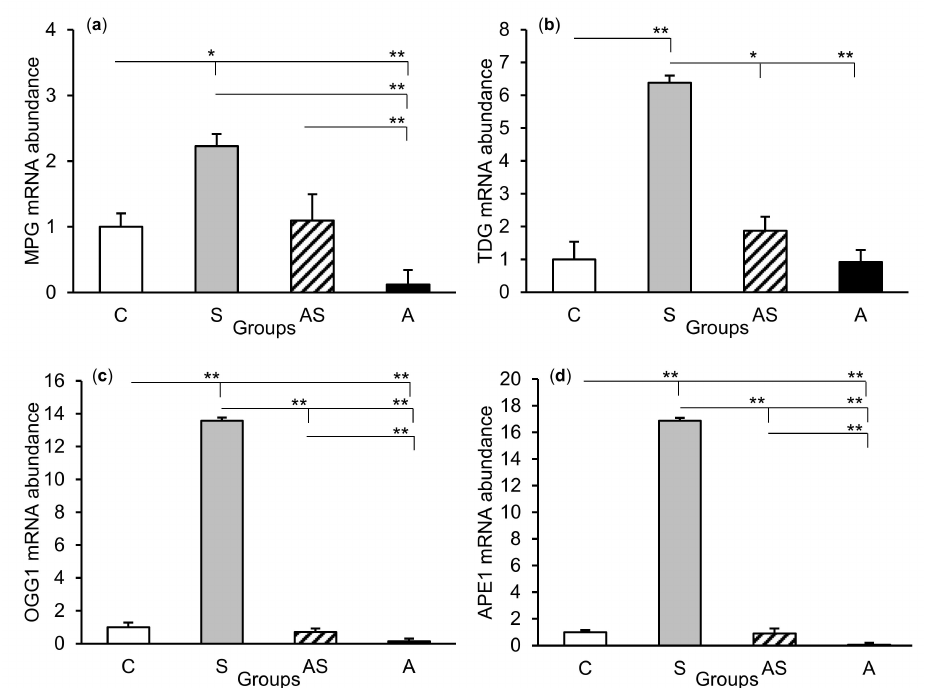
Figure 4. Relative mRNA abundance (mean ± SEM) of N-methylpurine-DNA glycosylase (MPG), ( a ) thymine-DNA glycosylase (TDG), ( b ) 8-oxoguanine glycosylase (OGG1), ( c ) and AP-endonuclease 1 (APE1), ( d ) in the central amygdaloid nucleus of sheep treated with: vehicle (C), vehicle and stressful stimuli (S), allopregnanolone and stressful stimuli (AS), and allopregnanolone alone (A). Significance of di ff erences: * p < 0.05, ** p < 0.01.